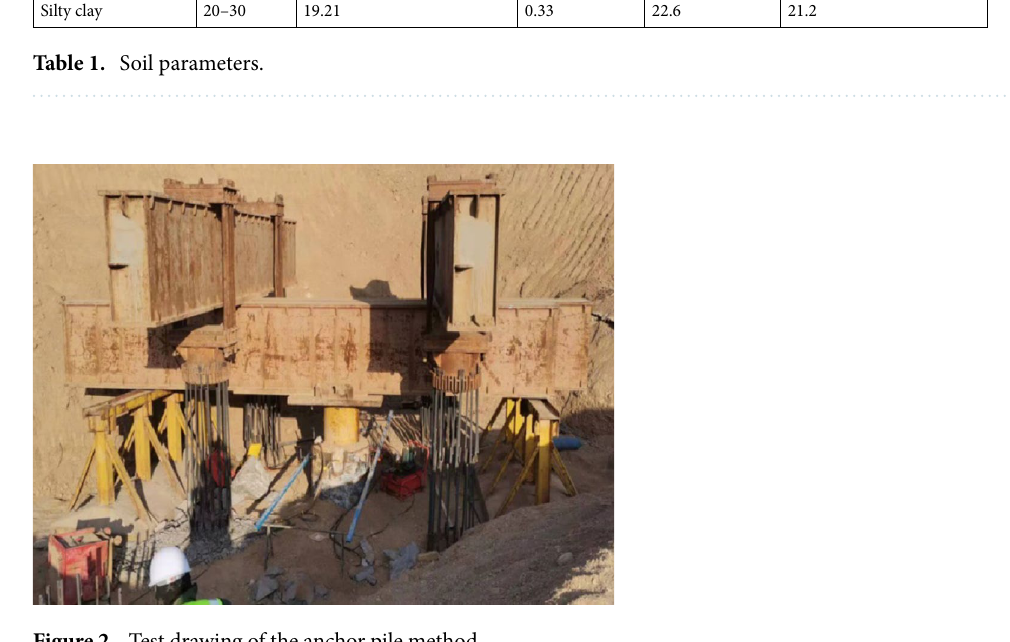
Figure 2. Test drawing of the anchor pile